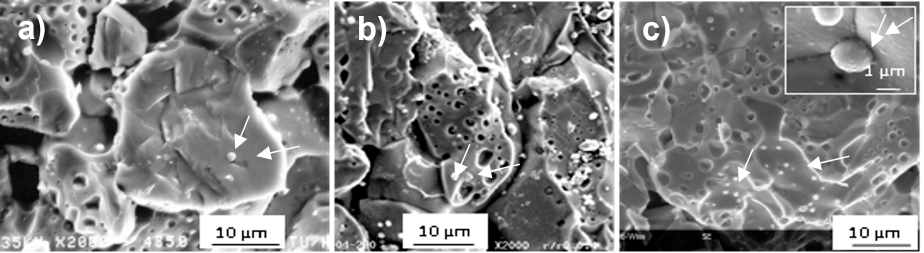
Figure 4. Secondary image of SF14 recorded in ( a ) 1991, ( b ) 2003, and ( c ) 2014. (N.B. the samples SF2 and SF4 were not examined by SEM). and SF4 were not examined by